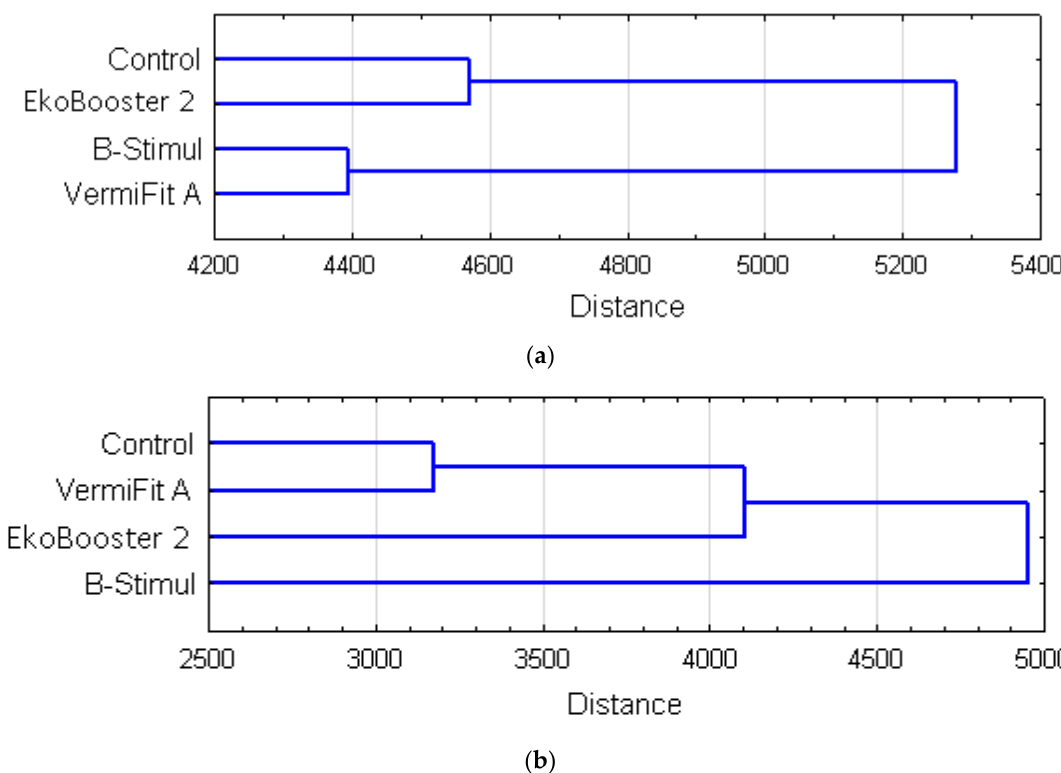
Figure 6. Dendrogram presenting the similarity between the chemical compositions of Stuttgarter Riesen ( a ) and Rote Laaer ( b ) bulbs in relation to the biostimulant fertilizers (Euclidean, Ward’s algorithm).